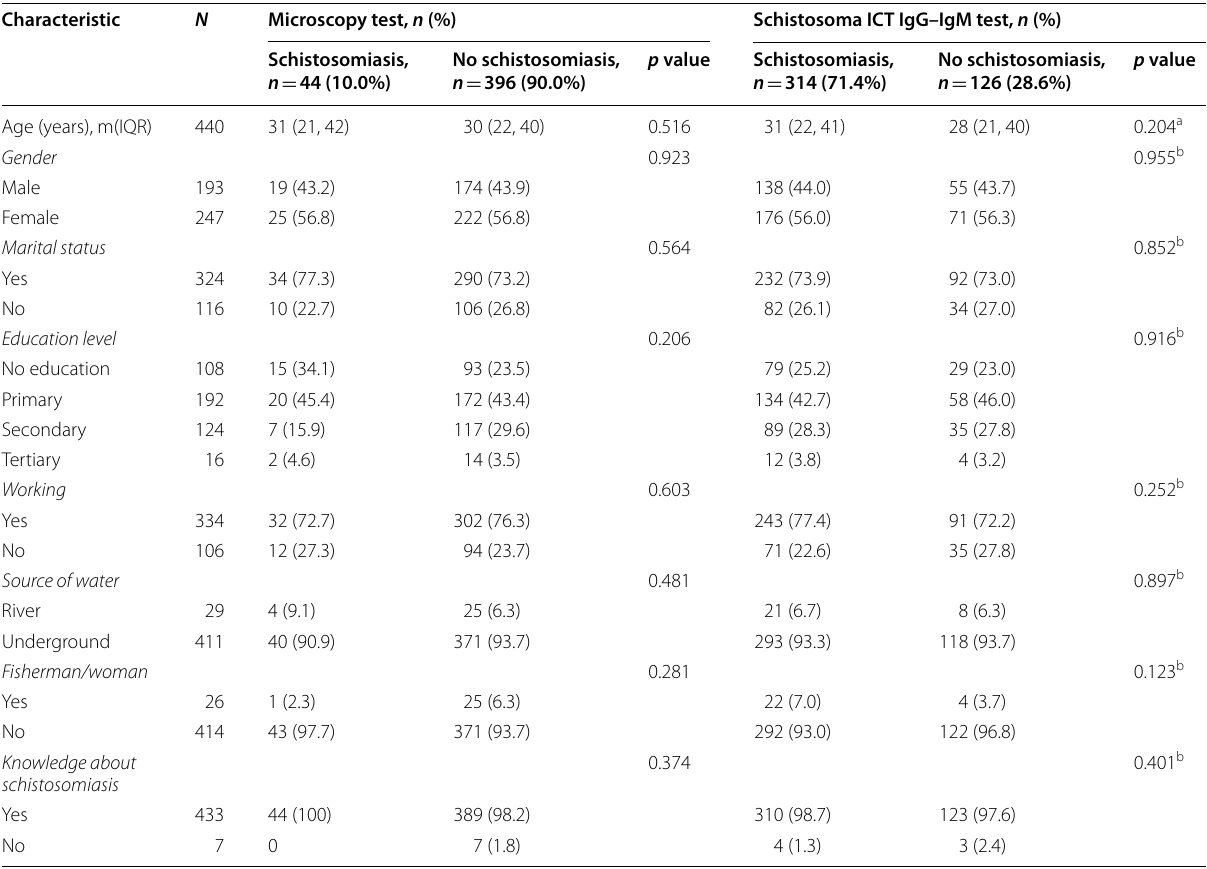
N -number of complete values; m (IQR)-median- (interquartile range); n (%)-frequency (percent) a Wilcoxon rank sum test b Chi-square